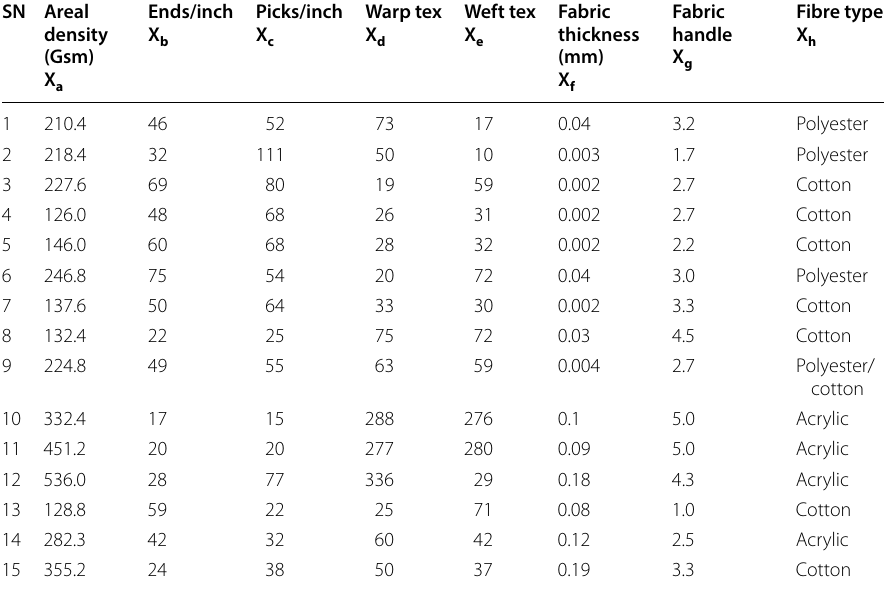
Table 3 Properties of the studied fabric